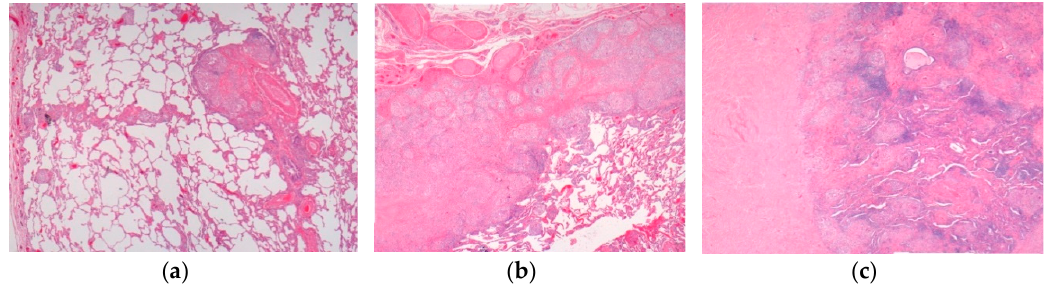
Figure 2. Pulmonary sarcoidosis. ( a ) Pulmonary sarcoidosis. ( b ) Pulmonary nodular sarcoidosis. ( c ) Pulmonary fibrotic sarcoidosis. H&E. Magnifications 20×, 50×.